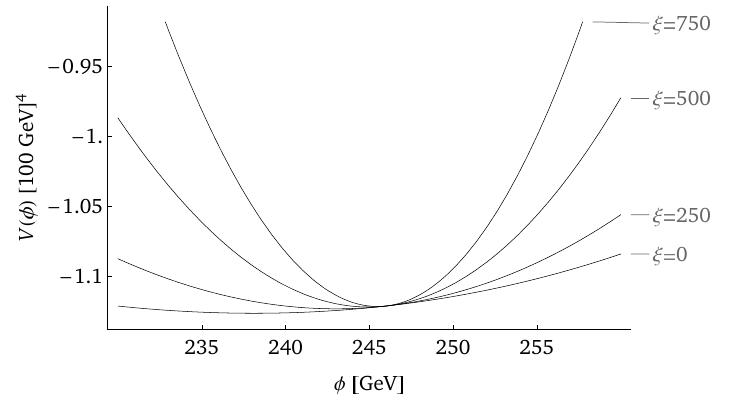
Figure 1 . The hard part of the 2-loop e(cid:11)ective potential, V h ( (cid:30) ) = V 0 ( (cid:30) ) + ~ V h versus the background (cid:12)eld (cid:30) . The parameters are chosen such that (cid:30) m (125 GeV) 2 ; A j = (90 GeV) 2 . (cid:30) m 0